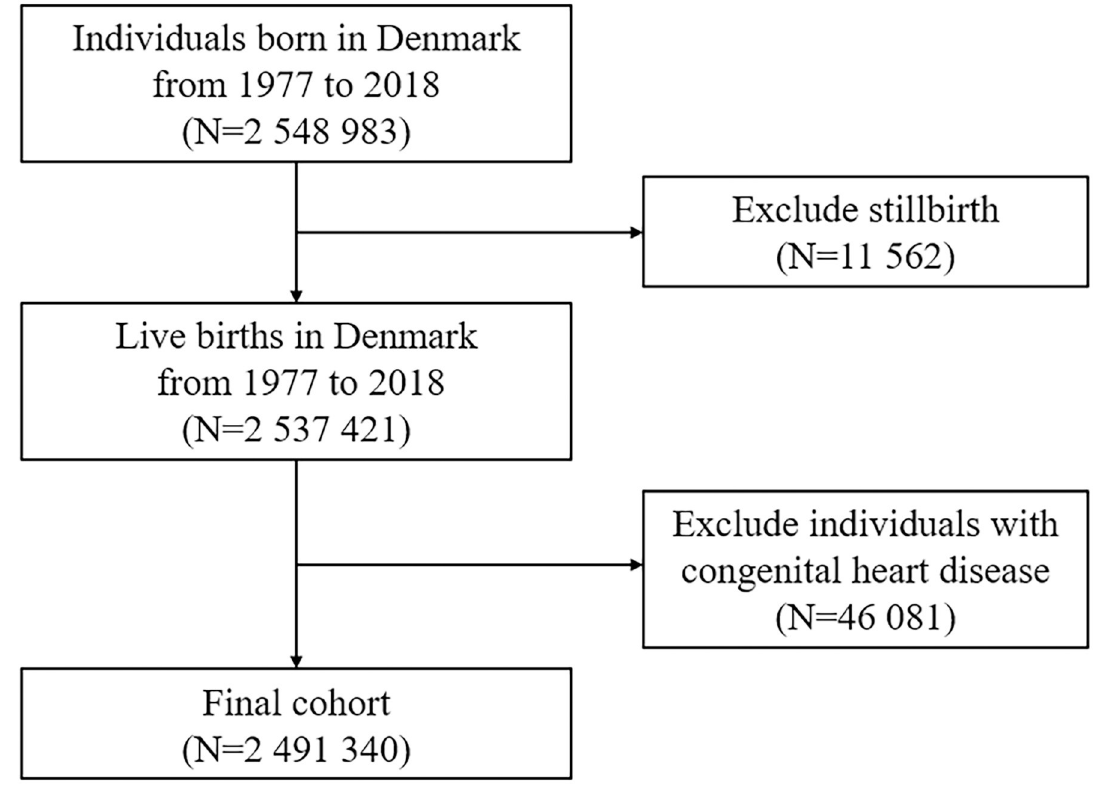
Fig 1. Flow chart of study